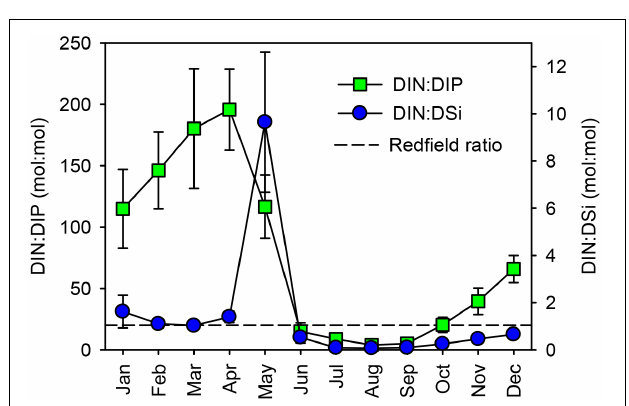
FIGURE 3 | The stoichiometric DIN:DIP and DIN:DSi ratios during 2012–2016 at the Nemunas River gaging station. Dashed lines indicate the theoretical Redfield ratio (DIN:DSi = 16:15 and DIN:DIP = 16:1). Averages ± standard deviations ( n = 6) are reported.